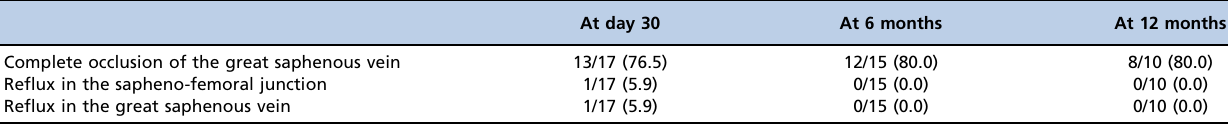
Table 4 - For limbs operated on using the radiofrequency technique: the number of patients showing venous occlusion or reflux at each of the time points studied as assessed by duplex ultrasound scan and the number of patients with each condition out of the total number of patients assessed